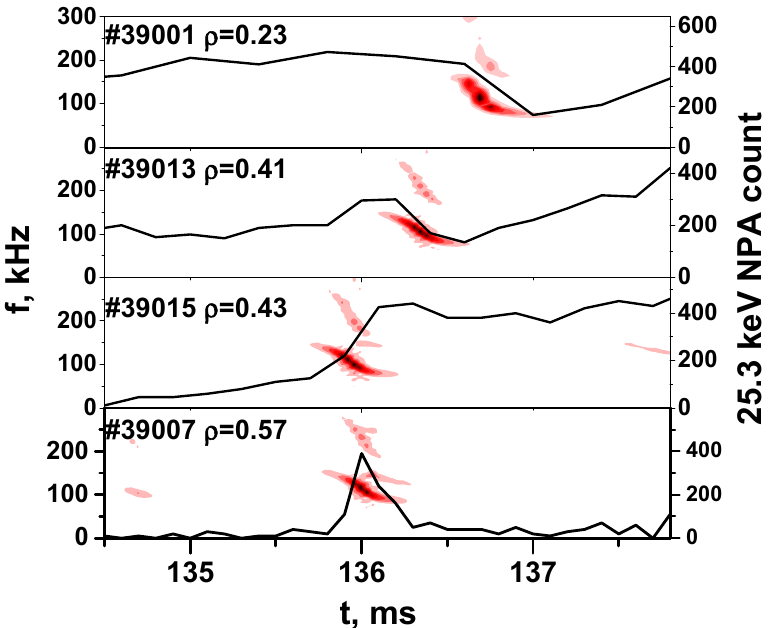
Figure 17. NPA 25.3 ± 1.2 keV atom count rate evolution with TAE development (discharges #39001, 39007, 39013, 39015). Normalized effective radius of the active signal source is increased from top to bottom.